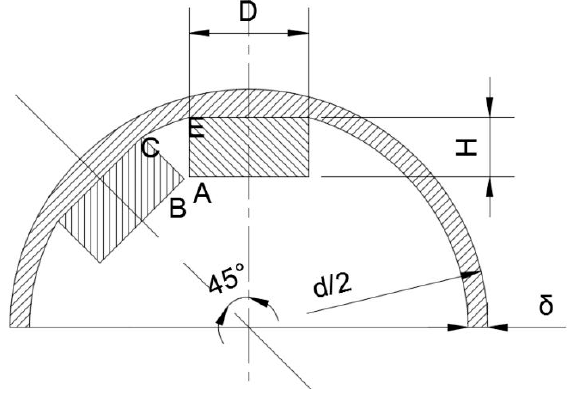
Figure 4. Cutaway view of the rotor.